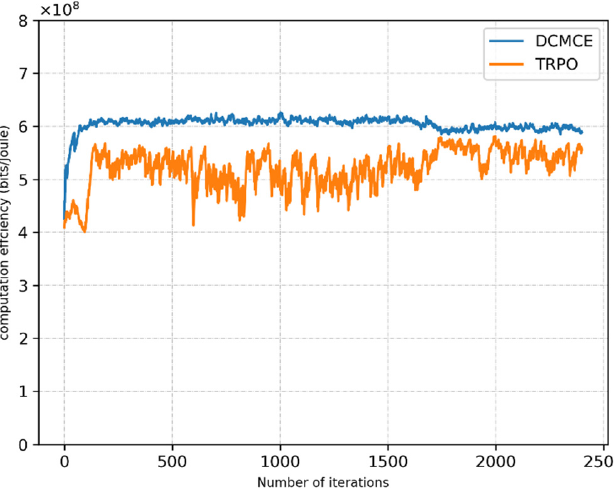
Figure 8. The convergence performance of algorithms.